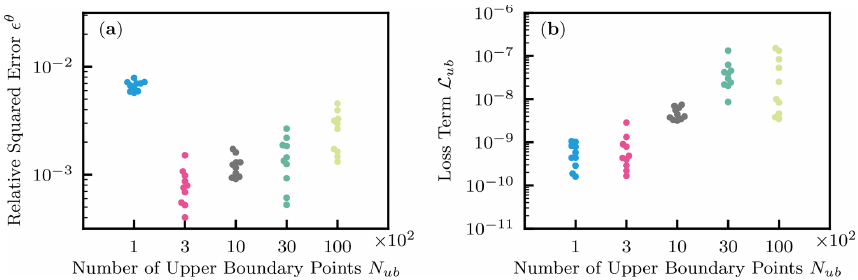
Figure 9. Homogeneous soil. (a) The effect of the number of upper-boundary data N ub on the relative squared error (cid:15) θ . (b) The effect on the loss term for the upper-boundary condition L ub